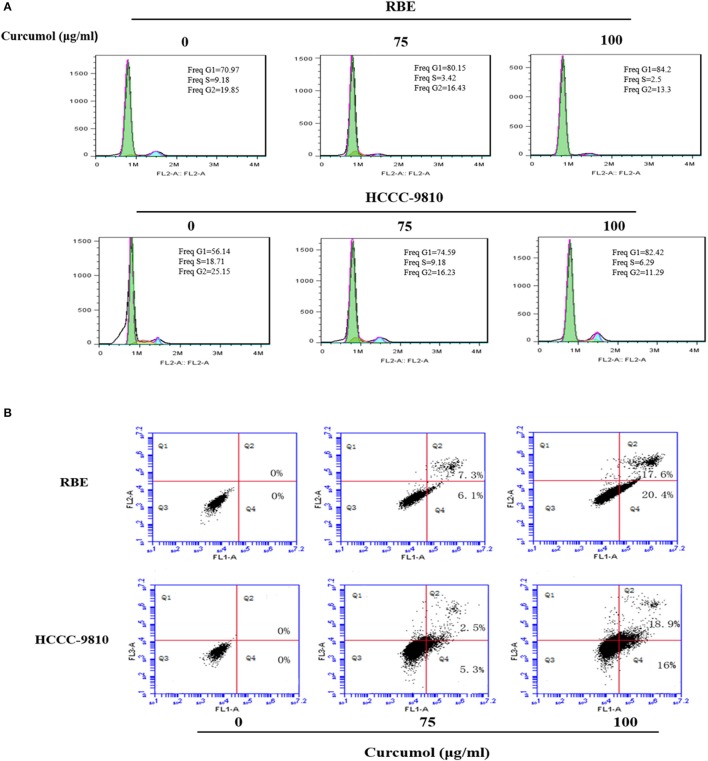
Curcumol blocks cell cycle progression at G1 phase and induces apoptosis in CCA cells. (A) Curcumol induced G1/S cell cycle arrest in RBE and HCCC-9810 cells. Representative flow cytometry images at 48 h of treatment are shown. (B) Curcumol induced apoptosis in RBE and HCCC-9810 cells following treatment with curcumol for 48 h. Representative dot plots are shown.